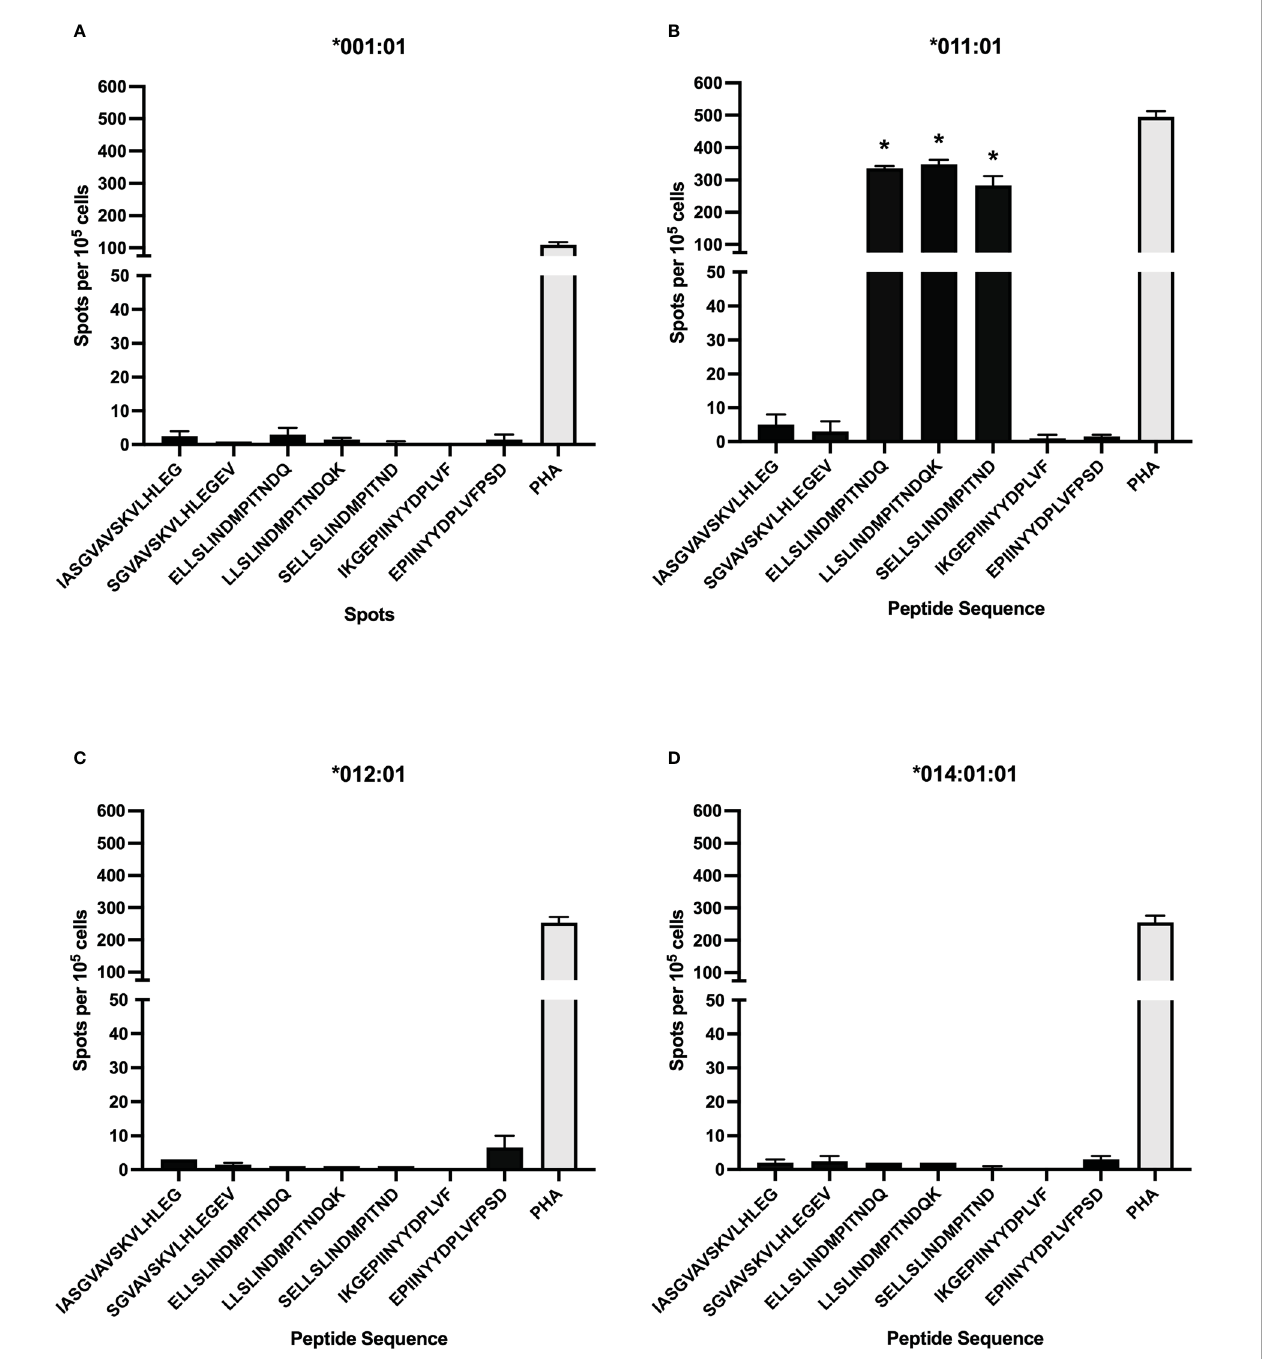
FIGURE 4 CD4 + T cell response to computationally predicted peptides presented by arti fi cial antigen presenting cells (aAPC). Synthetic peptides computationally predicted to bind strongly to select BoLA-DRB3 alleles used to stimulate CD4 + T cells after loading to aAPCs expressing BoLA-DR and CD80 molecules. DRB3*011:01 predicted peptides, with a core sequence of INDMPITND, were observed to induce T cell activation (B) while those predicted to bind to *001:01 (A) , *012:01 (C) , and *014:01:01 (D) did not. Cells were stimulated with 5 m g/mL PHA as a positive control. Data presented as mean ± SEM, p < 0.05 was considered signi fi cant and indicated by